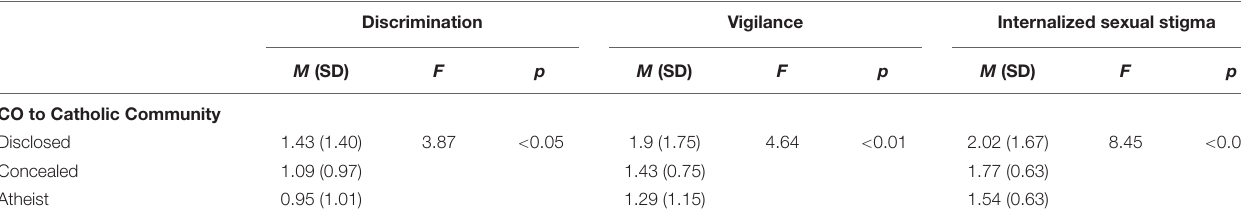
TABLE 6 | Means and standard deviations for discrimination, vigilance, and internalized sexual stigma (ISS) by CO to Catholic